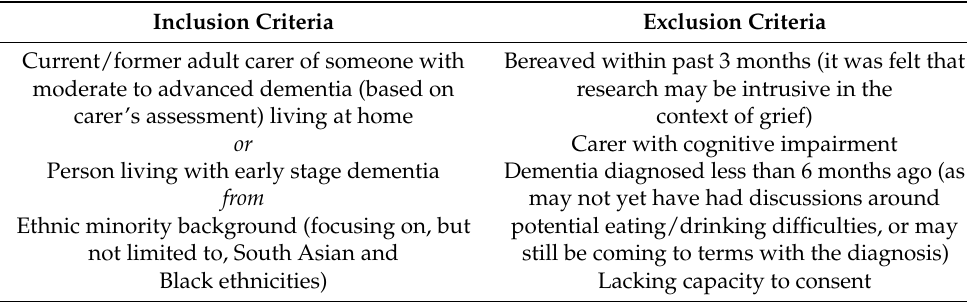
Table 1. Inclusion and Exclusion